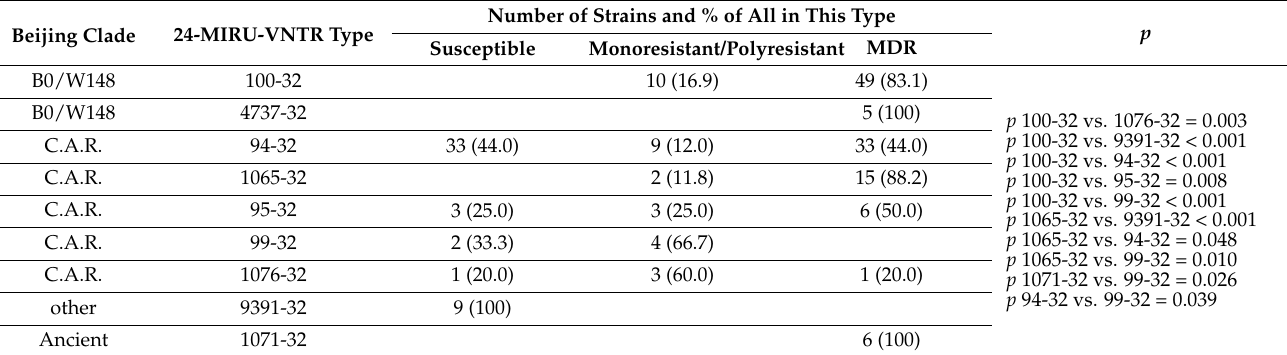
Table 6. Drug resistance of the main MIRU-VNTR